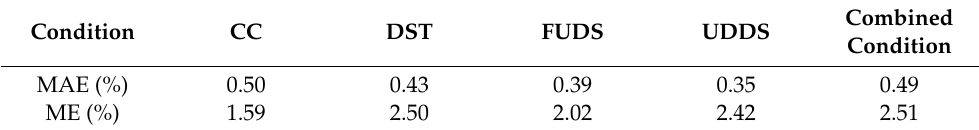
Figure 7. The estimation verification of SOC: ( a )–( e ) The estimation performances of SOC under different working conditions. ( f )–( j ) The estimation error under each working condition (25 °C). Table 2. MAE and ME for SOC estimation results (sampling time 1 s).